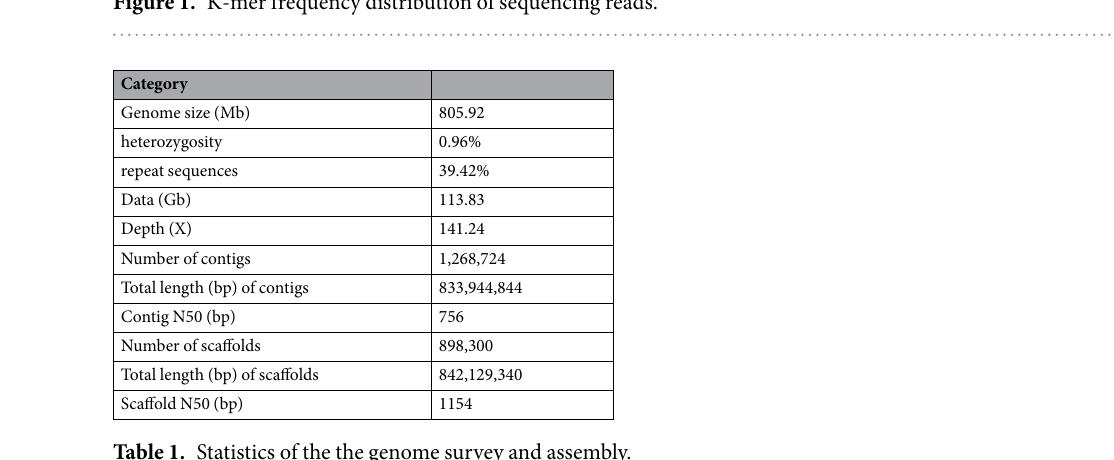
Figure 1. K-mer frequency distribution of sequencing reads.